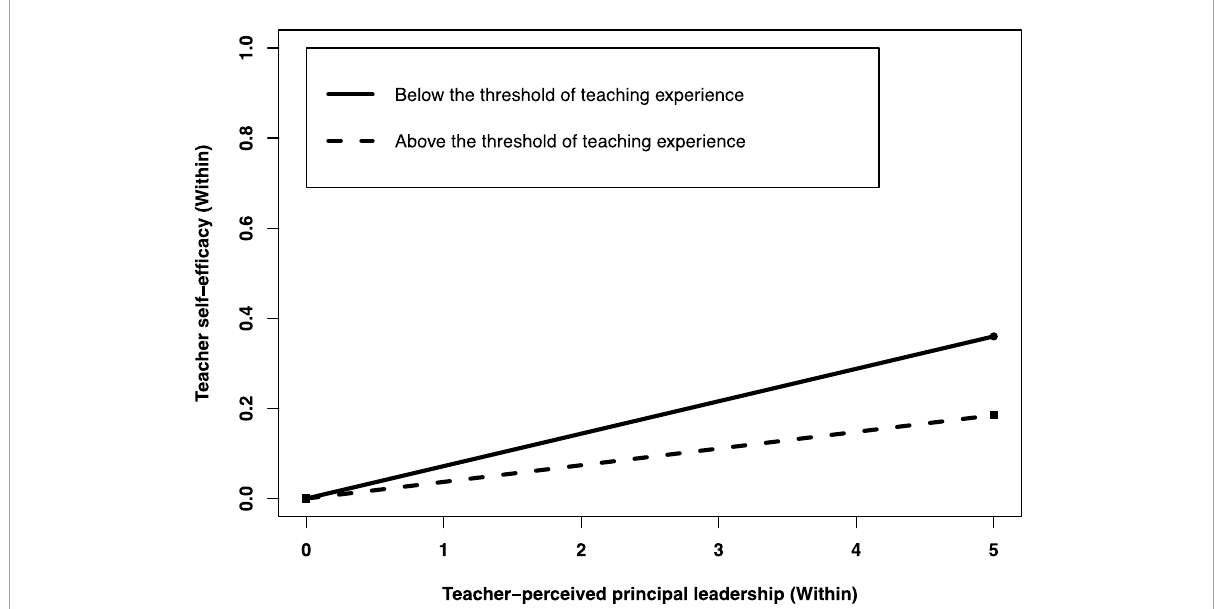
FIGURE3 Teaching experience as a moderator of the indirect effect between teacher-perceived principal leadership and teacher self-efficacy through teacher collaboration at the within-group level. Functions are graphed for two levels of positive coping: Teaching experience below and above a threshold.